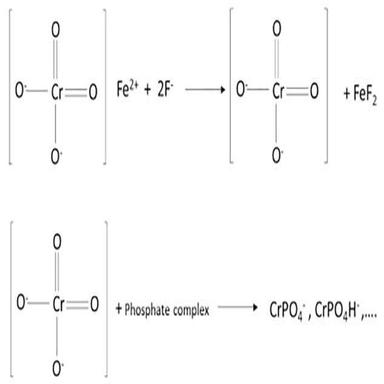
ToF-SIMS positive ion mass spectra (a) negative ion mass spectra at the different depths between b) 0 to 100 m/z and c) 100 to 200 m/z